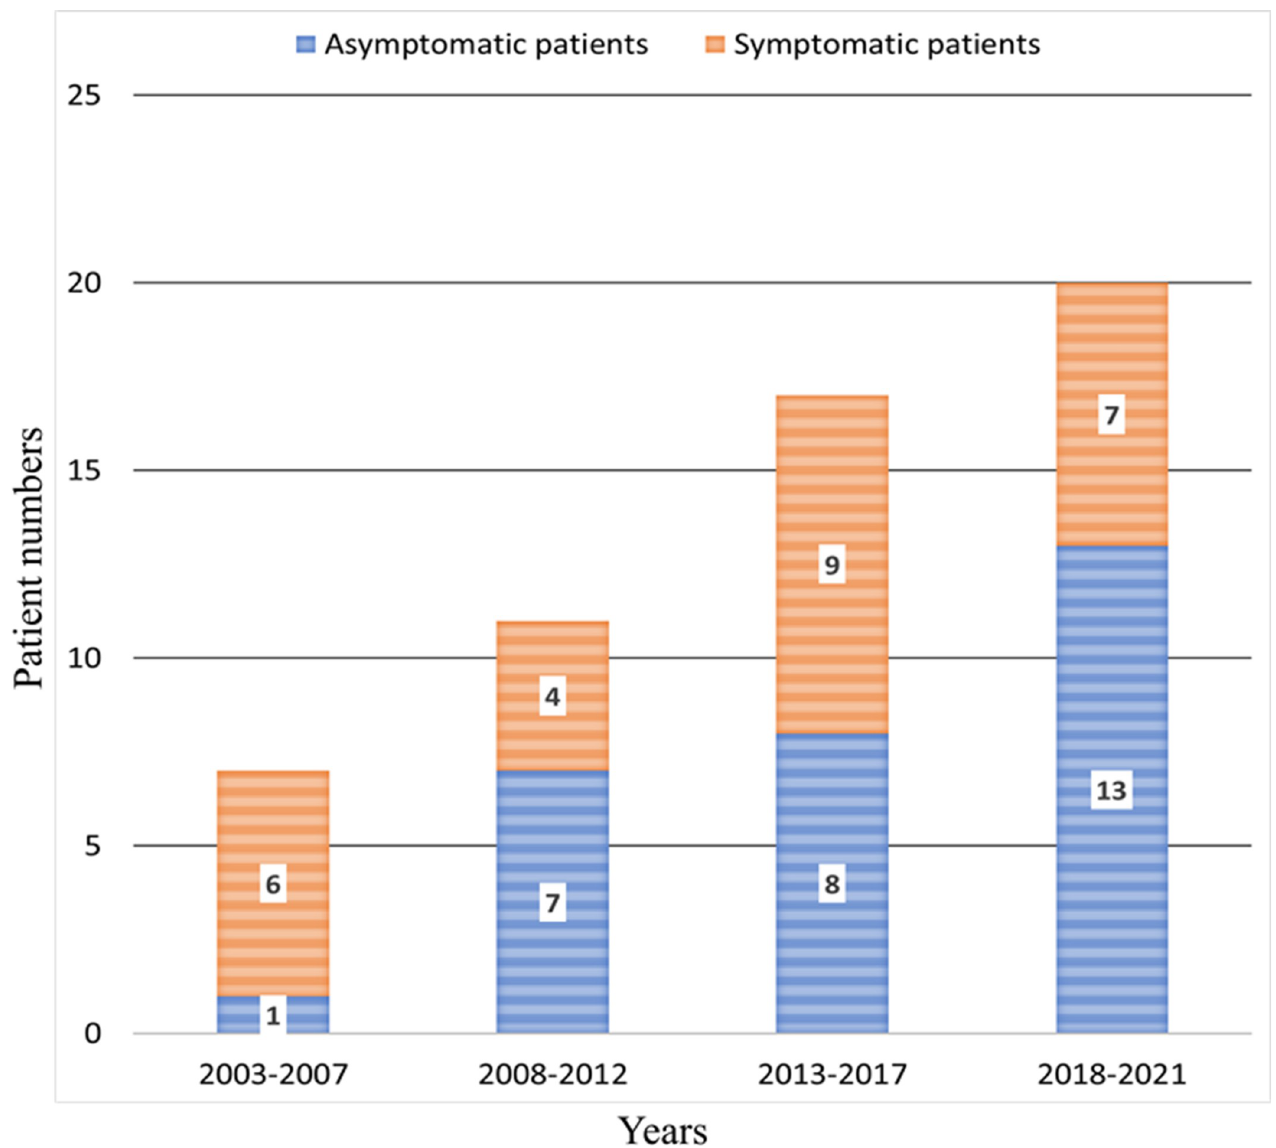
Fig 1. Number of patients diagnosed with pulmonary arteriovenous malformation from 2003 to